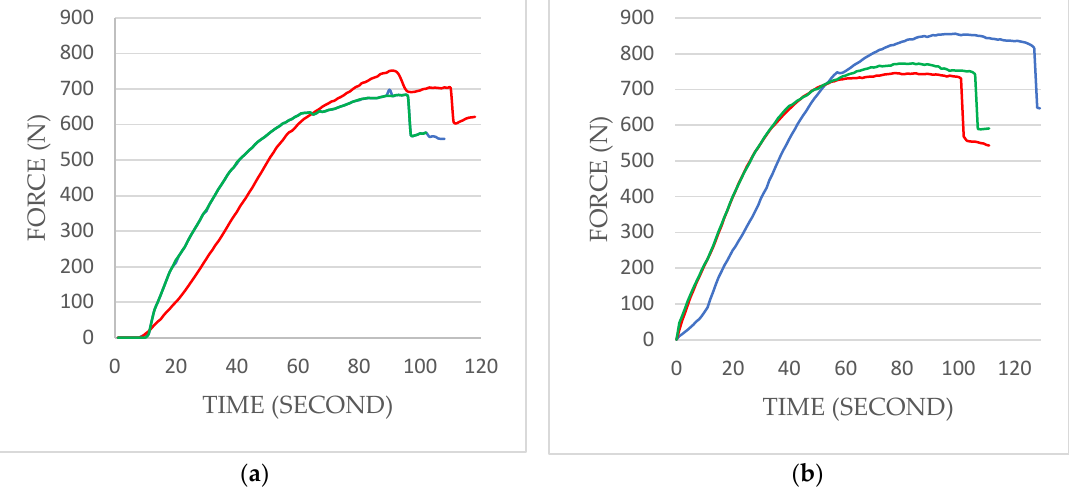
Table 2. Values of the maximum breaking loads in single-load failure tests on three specimens each. TX Ø4.0